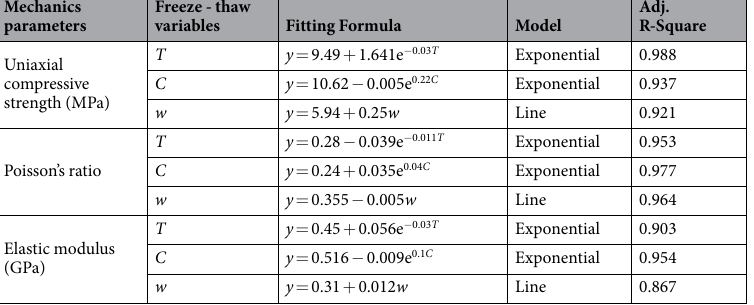
Table 1. Equations fit to the relationships between mechanics parameters of frozen-thawed coal and freeze- thaw variables. Note : T -LN 2 freezing time (min); C -Freeze-thaw cycles; w - Moisture content of coal samples